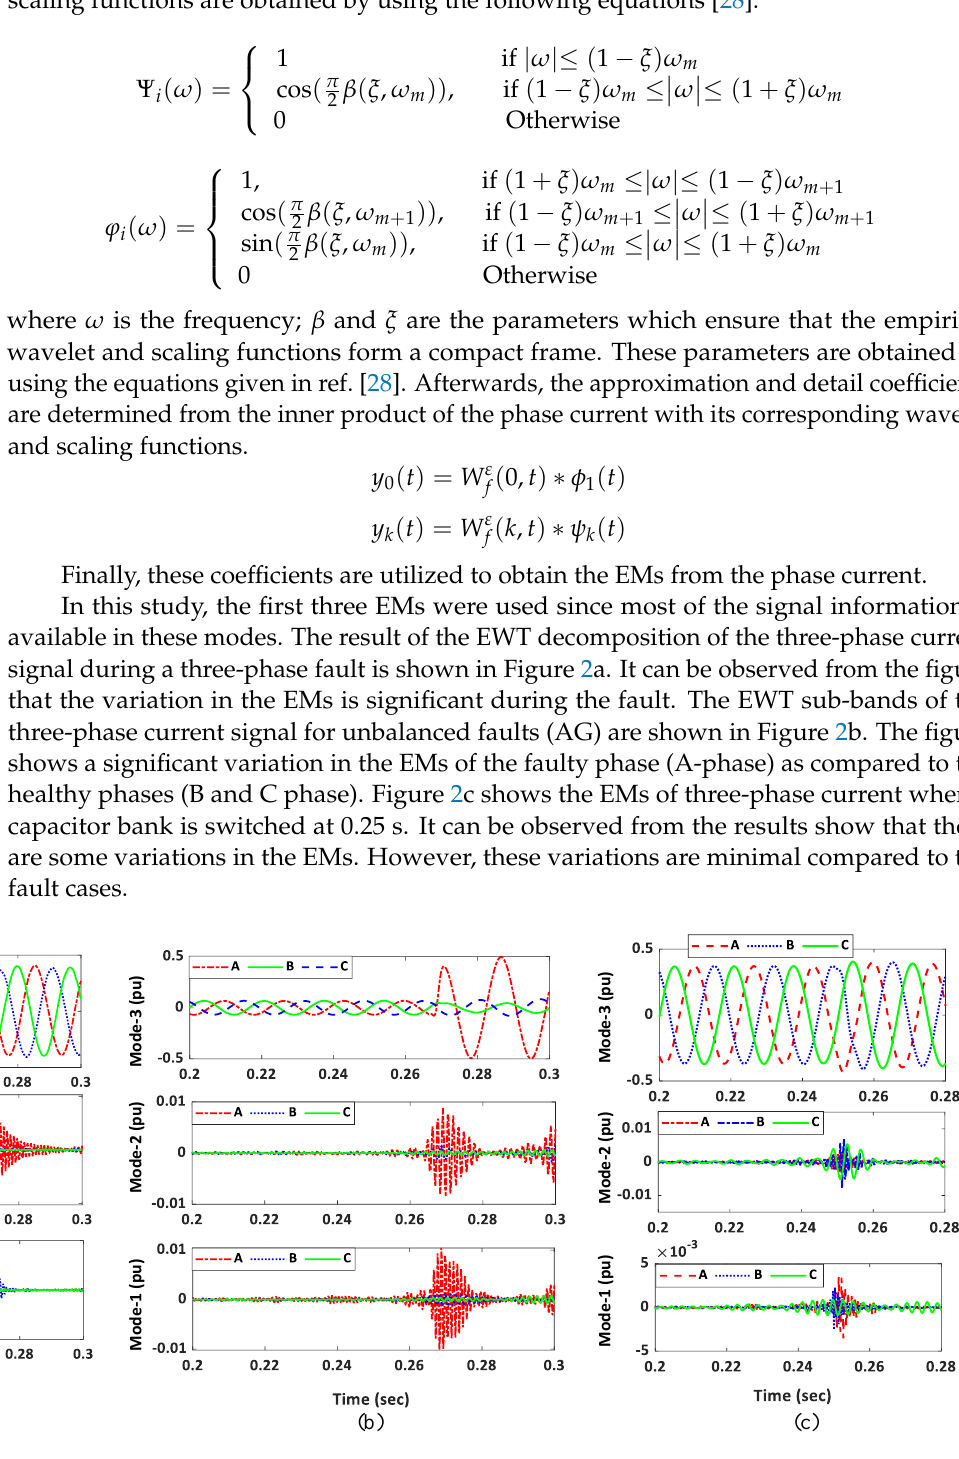
Figure 2. First three EMs obtained during ( a ) three-phase current; ( b ) AG fault; ( c ) capacitor switch- ing event.